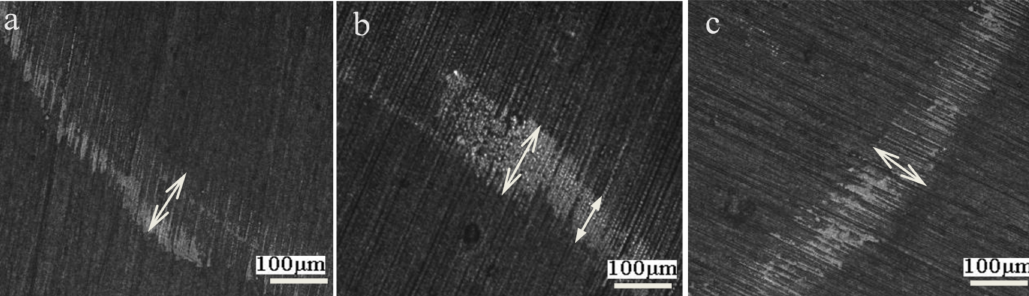
Figure 6. 2D profiles of the wear tracks observed by OM ( a ) G1; ( b ) G2; and ( c )